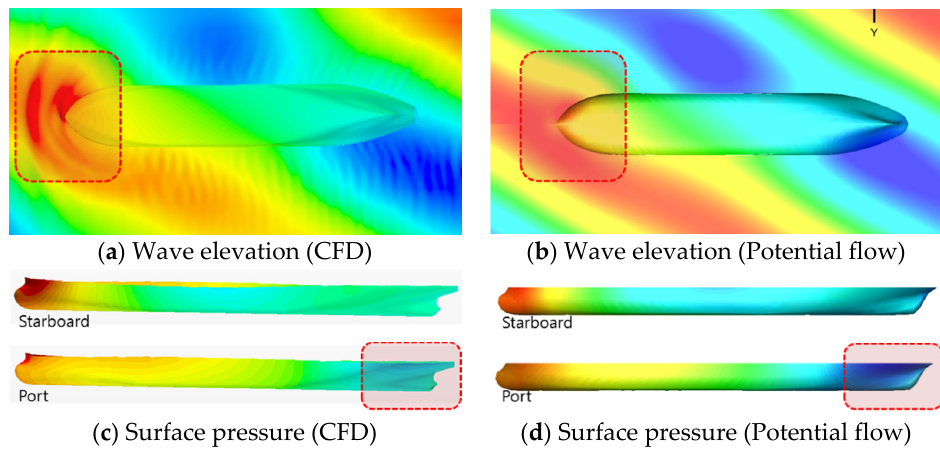
Figure 18. Wave elevation and surface pressure on KVLCC2: V = 6 knots, β = 60 deg, λ /L = 0.85.